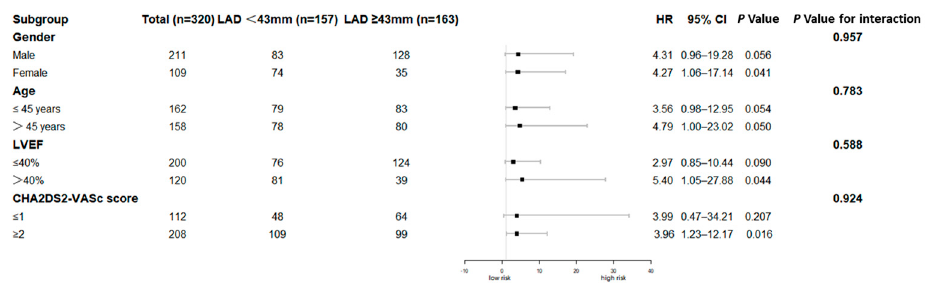
Figure 4. Subgroup analysis for associations between left atrial diameter and thromboembolisms in patients with left ventricular noncompaction. CI, confidence interval; HR, hazard ratio; LAD, left atrial diameter; LVEF, left ventricular ejection fraction.